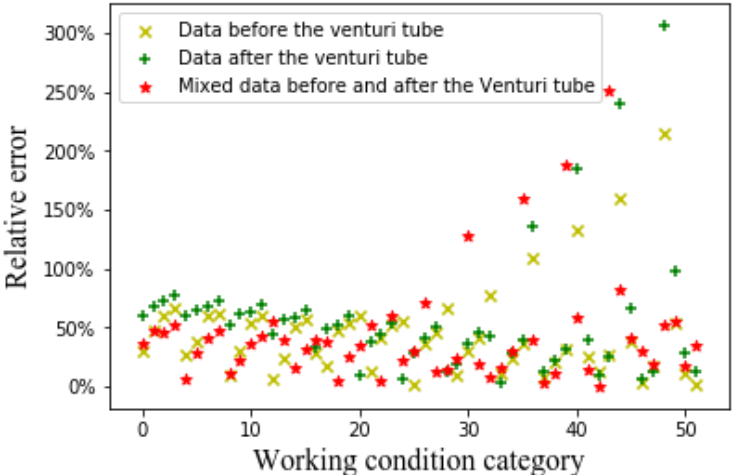
Figure 5. Relative error of GVF obtained from ECT images.